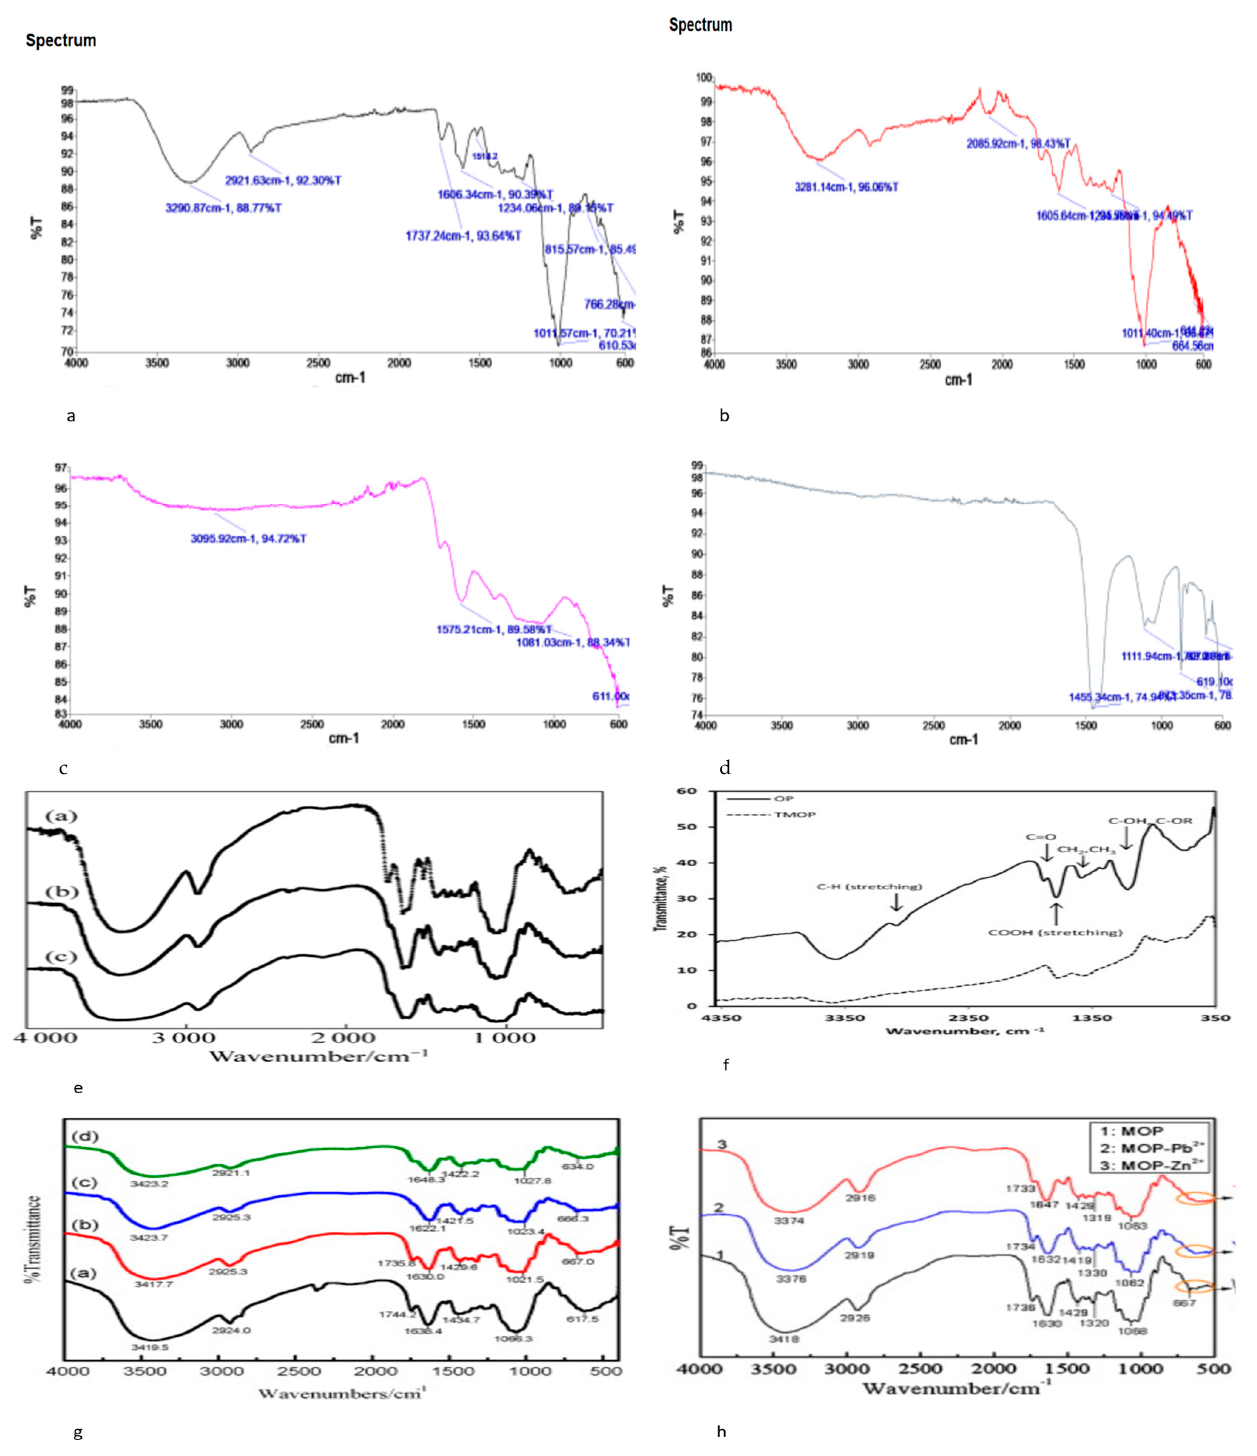
Figure 4. ( a ) FTIR spectra of physically modified orange peel, ( b ) chemically modified OP, ( c ) ther- mally modified OP at 300 °C, ( d ) thermally modified OP at 500 °C (this study), ( e ) OP, chemically modified OP, chemically modified OP after adsorption [88], ( f ) OP, thermally modified OP [66], ( g ) FTIR spectra of OP, MOP, and MOP after adsorption [89], ( h ) FTIR spectra of OP, MOP, and MOP after adsorption [90].